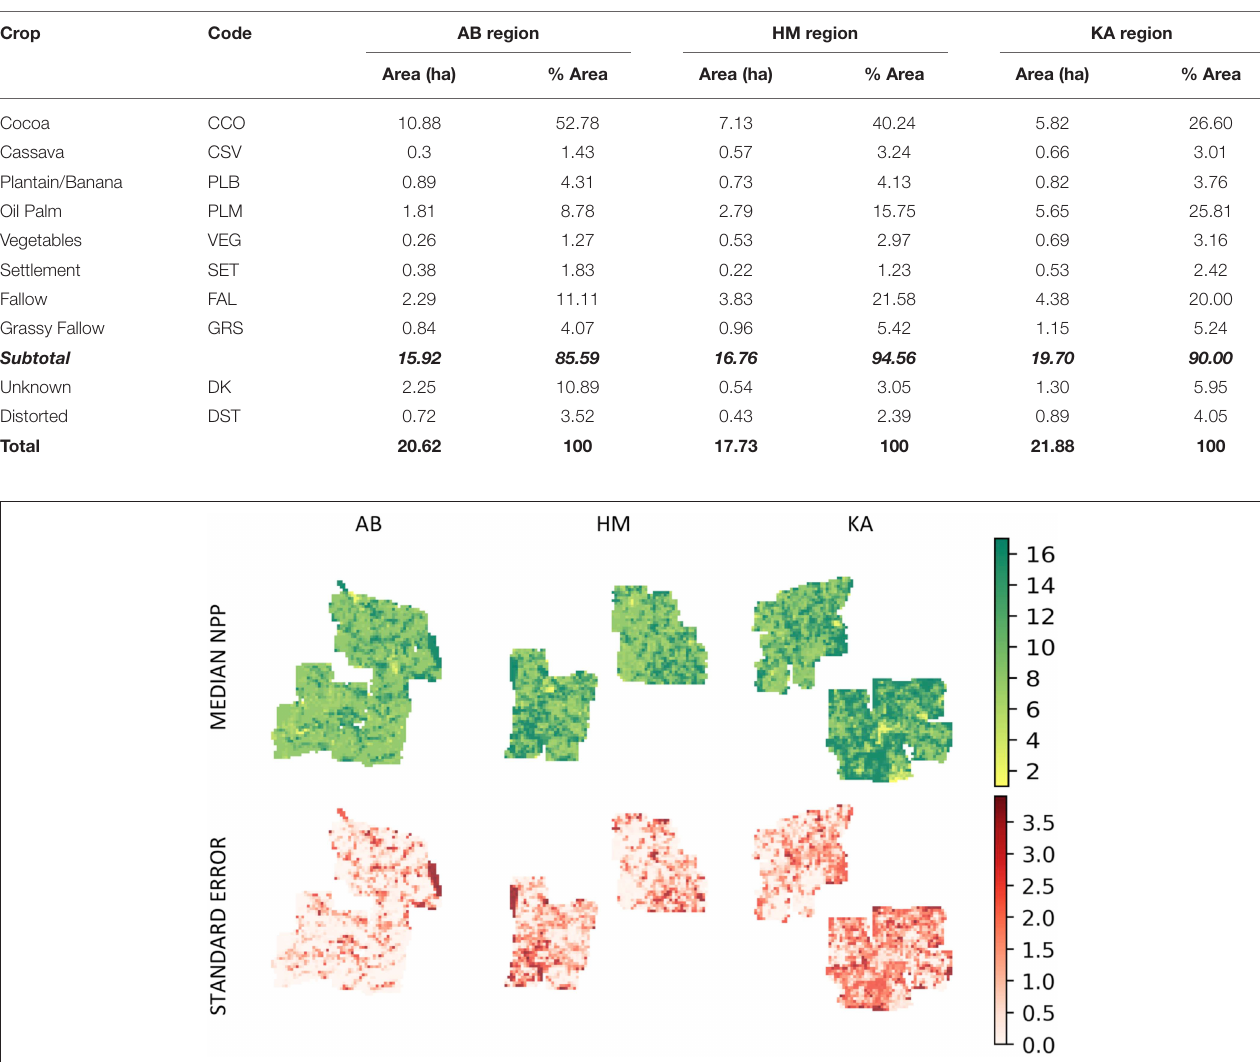
TABLE 3 | Land use codes, area covered per land use, and percent land use for all the regions. Crop